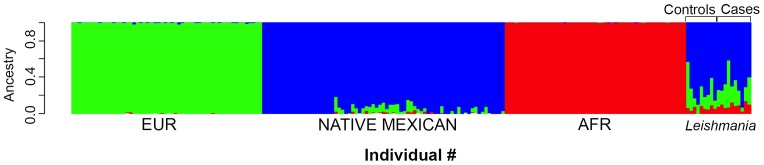
Population structure analysis.Genome wide SNPs (299,411) were used to calculate the individual ancestry proportion of the “Leishmania” group, assuming the three principal ancestral populations (K = 3). Green bars correspond to EUR (individuals with European ancestry), blue bars correspond to individuals with Native Mexican ancestry and red bars labeled as AFR correspond to individuals with African ancestry. The last block on the far right labeled “Leishmania” corresponds to the 9 controls and 10 cases used in this study. The X axis represents individual references for each population and the Y axis represents the ancestry proportion for each individual in a scale from 0 to 1 (colors included in each bar). The block labeled as Leishmania shows that all samples are essentially Mexican-mestizo.